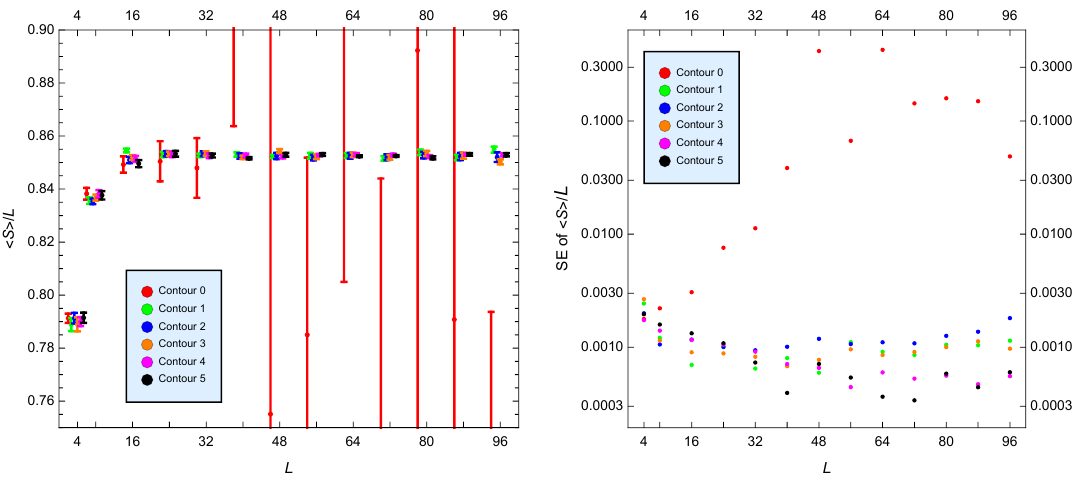
Figure 2 . Left: the action density as a function of lattice size. Di(cid:11)erent contours are separated horizontally for clarity. Right: the standard error of the action density. The various contours are colour marked.